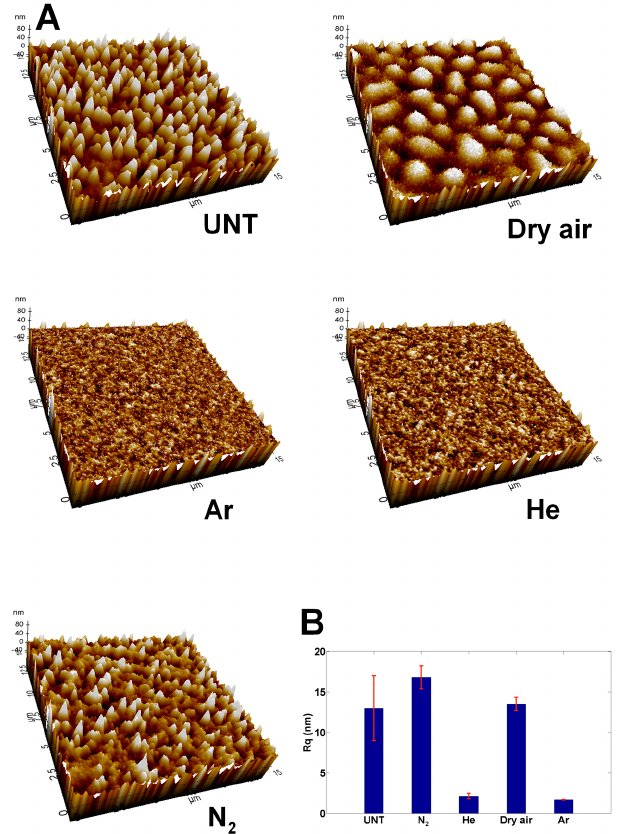
Figure 2. ( A ) 15 × 15 µ m 2 atomic force microscopy (AFM) micrographs before and after different optimized plasma treatments (Ar: 11.3 J/cm 2 ; He: 22.6 J/cm 2 ; N2: 45.2 J/cm 2 and Dry air: 45.2 J/cm 2 ). Z scale is set at 100 nm for all samples; ( B ) overview of the Rq roughness changes after the different optimized plasma